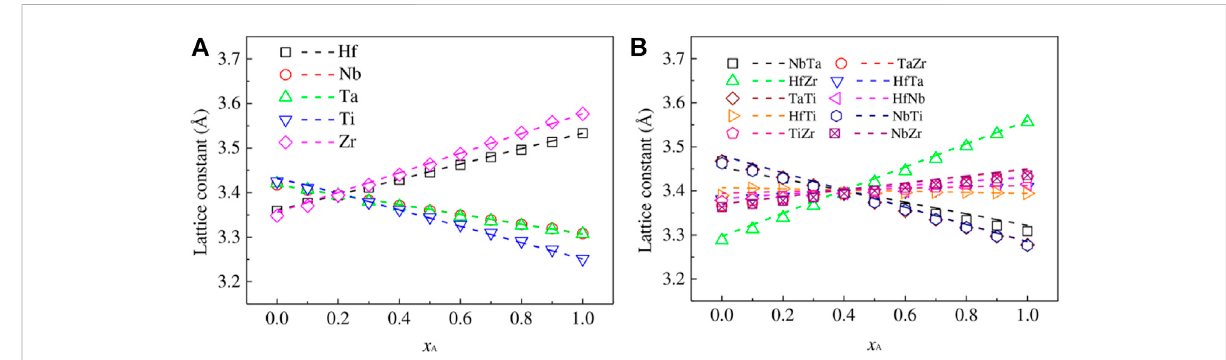
FIGURE 10 The fi nalmembersofthelatticeconstantsofthe1 – 4 (A) and2 – 3 (B) pseudo-binaryA x B 1-x alloysasafunctionofthemolarfraction.Insub fi gure (A) , A represents one of the Hf-Nb-Ta-Ti-Zr elements, and B represents the other four elements. In sub fi gure (B) , A represents two elements of Hf- Nb-Ta-Ti-Zr,whileBrepresentstheotherthree.ThelatticeconstantsthatconformtoVegard ’